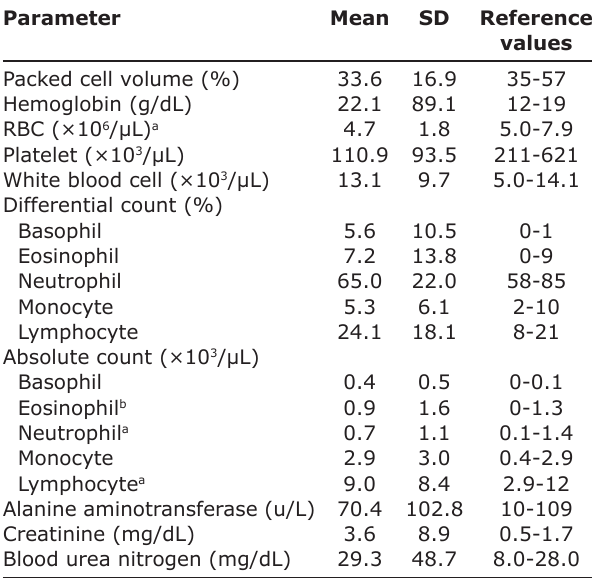
Table-2: Hematological and biochemical values of E. canis -seropositive dogs in Metro Cebu, Philippines. Parameter